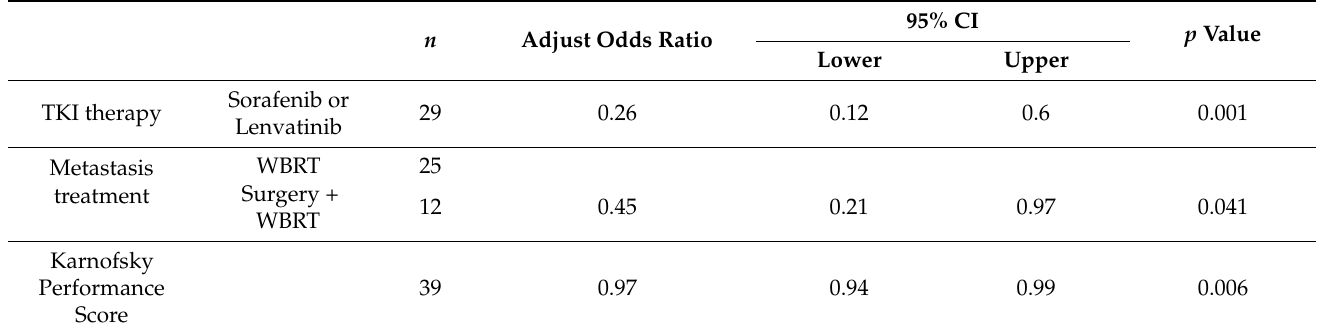
Table 4. Multivariate analysis for overall